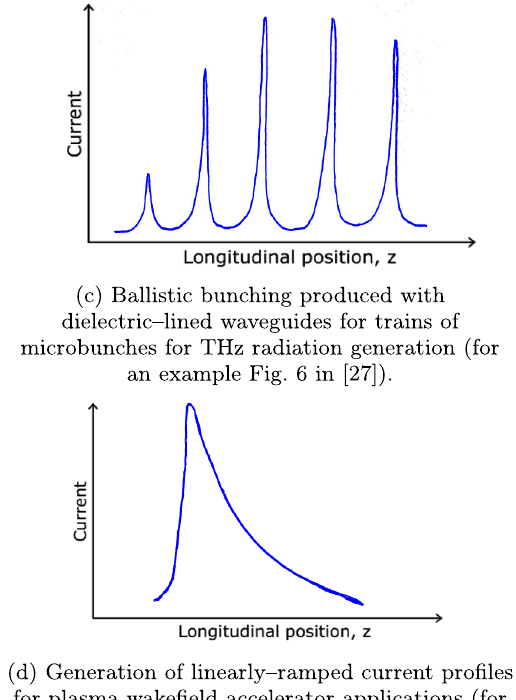
FIG. 2. Illustrations of current spikes induced by caustics in a variety of applications.